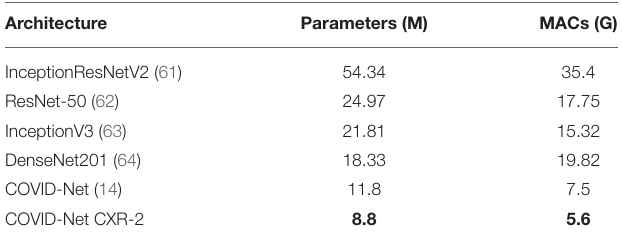
TABLE 2 | Architectural and computational complexity of COVID-Net CXR-2 network in comparison to COVID-Net (14) and other state-of-the-art computer vision architectures. Best results highlighted in bold.